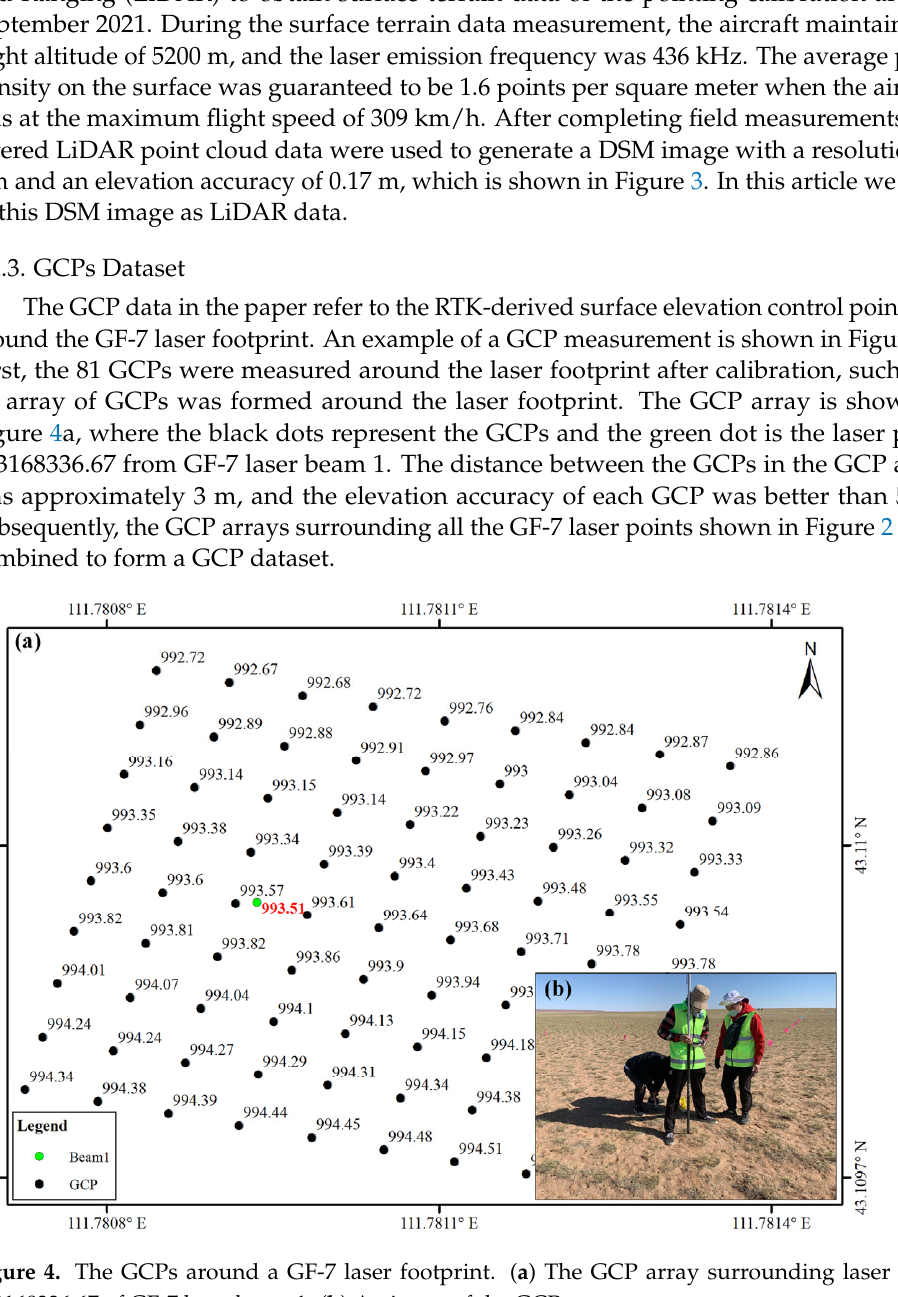
Figure 5. Flow chart of the proposed satellite laser calibration method without a field detector in the study .